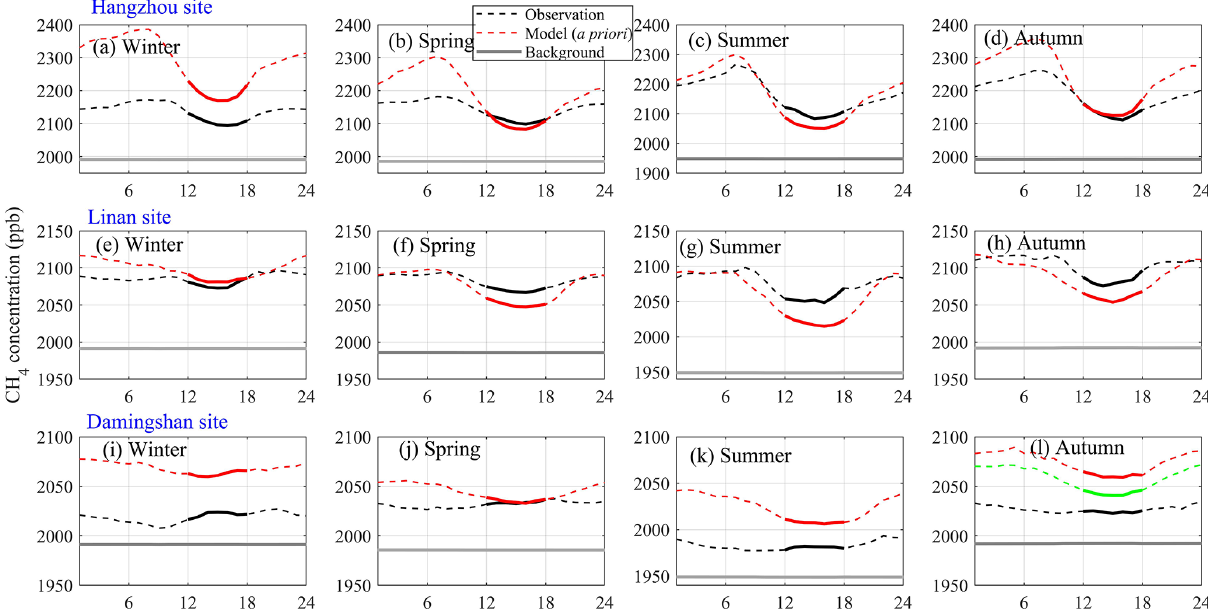
Figure 5. Seasonally averaged diurnal variations for the Hangzhou site in (a) winter, (b) spring, (c) summer and (d) autumn; for the Linan site in (e) winter, (f) spring, (g) summer and (h) autumn; and for the Damingshan site in (i) winter, (j) spring, (k) summer and (l) autumn. Note that because of 2 months of a data gap in autumn for the Damingshan site, the green line is for all September–November simulations, the red line only represents the simulation of the corresponding period for available observation data, and bold lines represent data between 12:00 and 18:00LT. Table 1. The a posteriori SFs for different categories in three cases for Hangzhou. Wetland: natural and agricultural wetland; waste: waste treatment; PRO: fuel exploitation; RCO: energy for buildings; others: the remaining anthropogenic emissions. For Case 1, there are three categories and 300% uncertainty for waste treatment. For Case 2, there are five categories, and the a priori uncertainty of 200% was used for each category. For Case 3, there are three categories and 200% uncertainty for waste